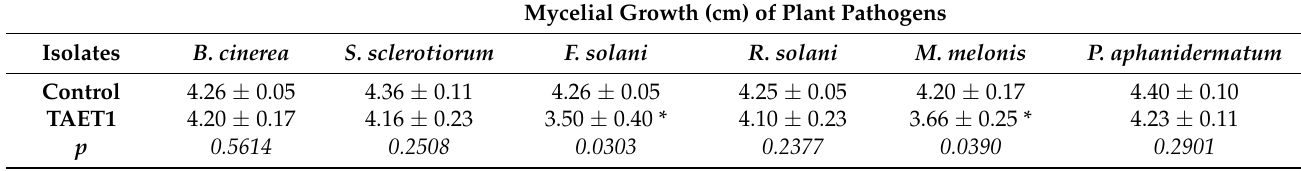
Table 3. Mycelial growth (cm) of phytopathogens on PDA medium due to exposure to Trichoderma aggressivum f. europaeum TAET1 volatiles vs. the growth control. * Means are significantly different (LSD) according to t students test ( p < 0.05). Mycelial Growth (cm) of Plant Pathogens Isolates